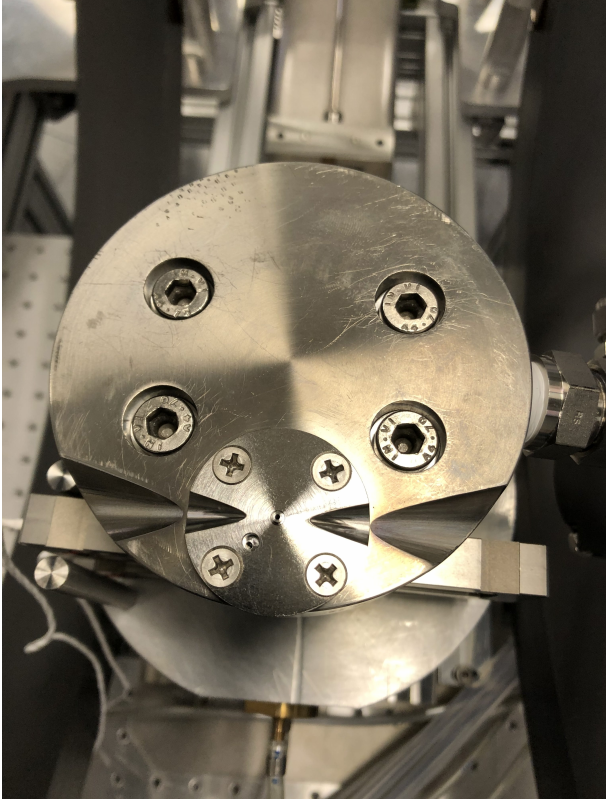
Figure 10. Nozzle mounted on the top of the compressor. The cone-shaped grooves follow the direction of the laser beam. At the lower left side of the nozzle, a needle for focus adjustment can be